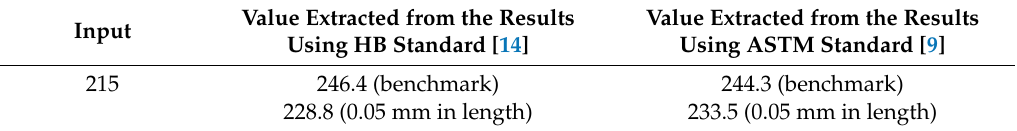
Table 4. Estimates of the Mode I critical energy release rate G I c (J/m 2